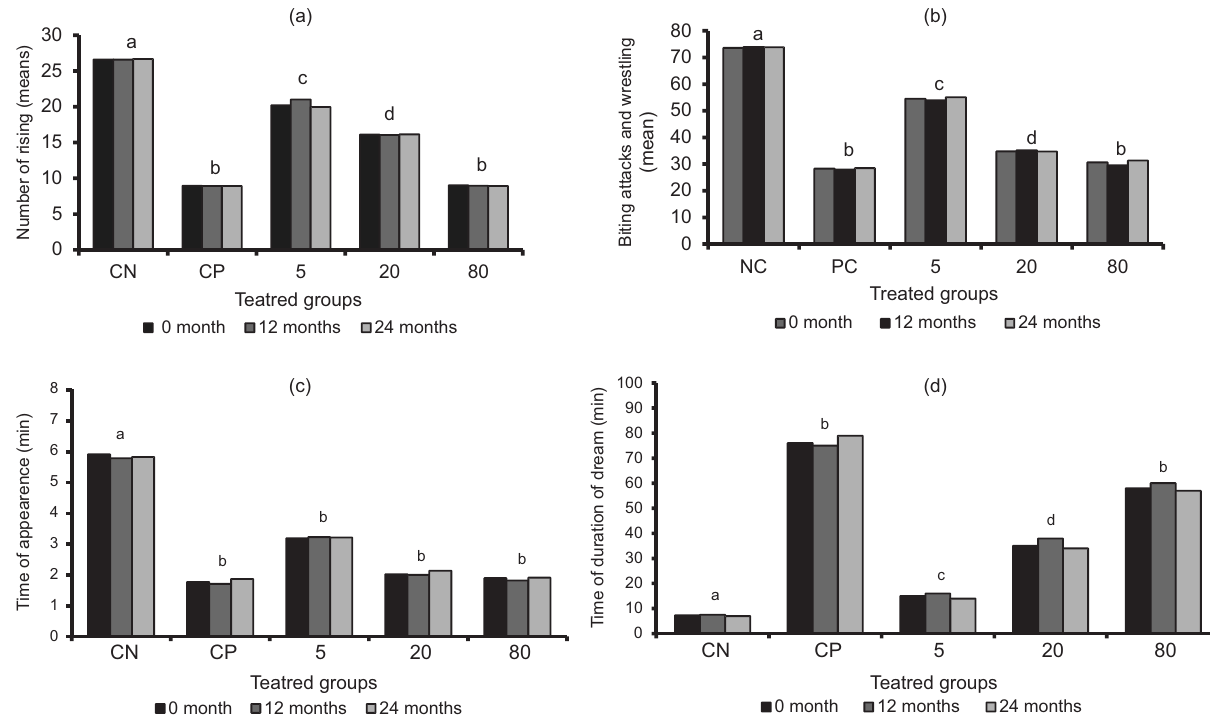
FIGURE 4 - Pharmacological evaluation in the time. (a) Results of open field activity in mice treated with Tilo ® tablets; (b) Results of aggressive study in mice treated with Tilo ® tablets; (c) Effect of Tilo ® tablets on Thiopental induced sleep in mice. Time of appearance of dream induced and (d) Effect of Tilo ® tablets on Thiopental induced sleep in mice. Time of duration of dream). Similar letter no significant for p < 0.05.